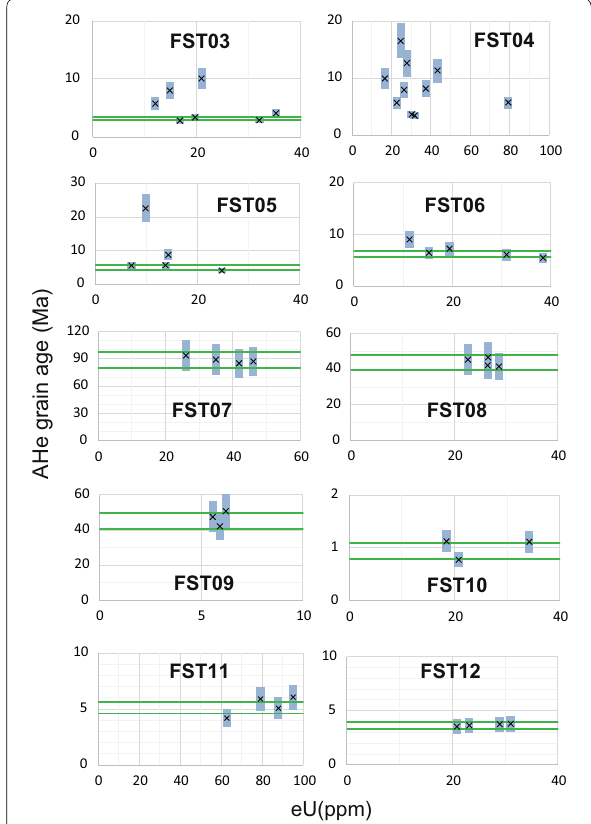
Fig. 2 Effective uranium (eU) ppm versus AHe grain ages (with errors indicated by 3σ). Two horizontal green lines show the upper ± and lower limits of the weighted mean ages, namely the and 95% confidence intervals. No green lines imply that the − weighted mean age was not considered meaningful because of poor